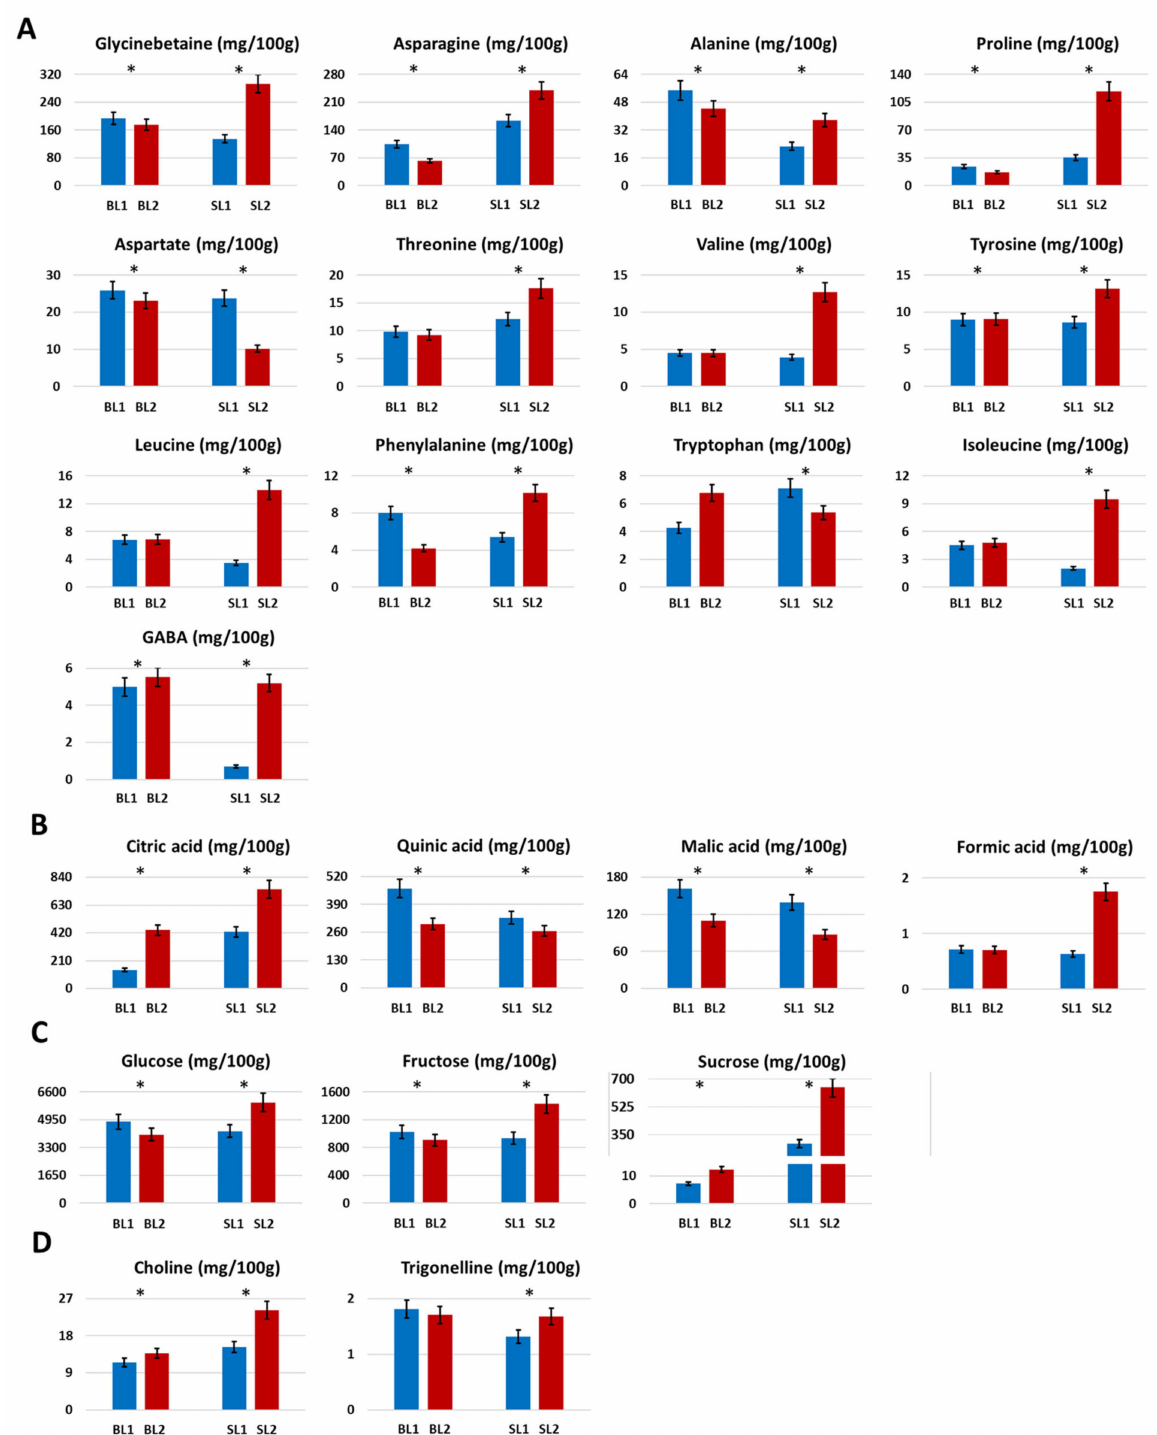
Figure 2. Histograms resulting from the quantitative NMR analysis of quantified compounds present in the Bligh-Dyer hydroalcoholic extracts of Goji berries cultivars Big Lifeberry (BL) and Sweet Lifeberry (SL) harvested in August (BL1, SL1) and October (BL2, SL2). ( A ) Sugars, ( B ) Organic acids, ( C ) Amino acids, ( D ) Other metabolites. Results were expressed as mg/100g ± SD of fresh sample. * p < 0.05 significantly difference between the two harvesting periods in the same cultivar, one-way